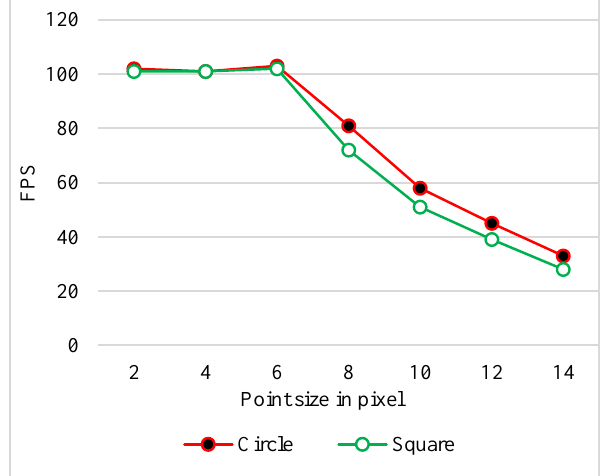
Figure 12. Influence of the variation of the point size on the FPS, JEHAY with a budget of 2Million, interpolation = paraboloid, LRU =